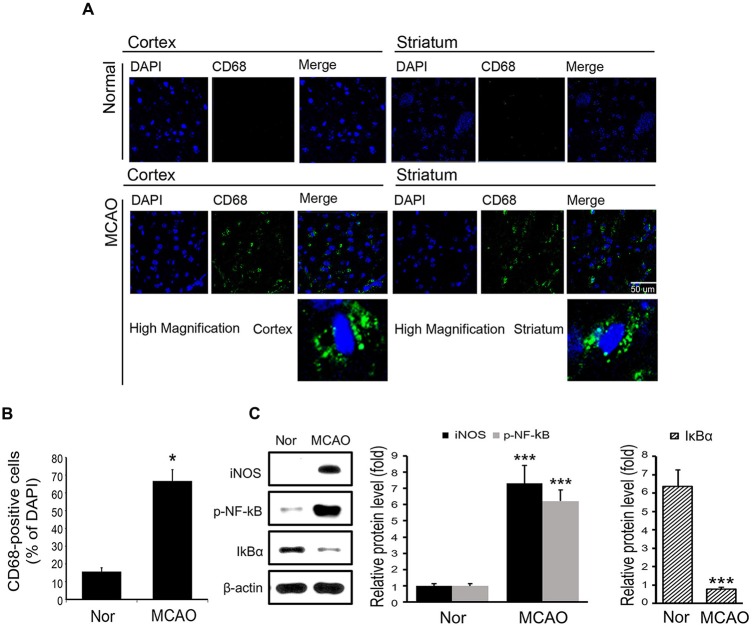
Expression levels of CD68, inducible NO synthase (iNOS), p-NF-κB and IκBα in mouse brain tissues. (A) Levels of CD68 (a marked of activated microglia) in brain tissues were assessed immunohistochemically. Images show CD68-positive cells (green) in the cortex of middle cerebral artery occlusion (MCAO) mice. CD68 expression was considerably higher in cortex in the 8 h MCAO mouse brain than in the control mouse brain. In addition, CD68-positive cells were observed in ischemic striatum. (B) A plot of CD68-positive cell percentages. Results are expressed as means ± SDs. Each experiment conducted 3 mice per conditions. Significant vs. normal, *p < 0.05 (paired T-Test with MCAO mice. (C) The protein levels of iNOS, p-NF-κB and IκBα in brain. Data are expressed as mean ± SDs, and each experiment conducted three repeats per conditions. Significant vs. normal, ***p < 0.001. Scale bar = 50 μm, CD68: green, 4′,6-diamidino-2-phenylindole (DAPI): blue, Nor: normal control group, MCAO: reperfusion 8 h after MCAO injury.